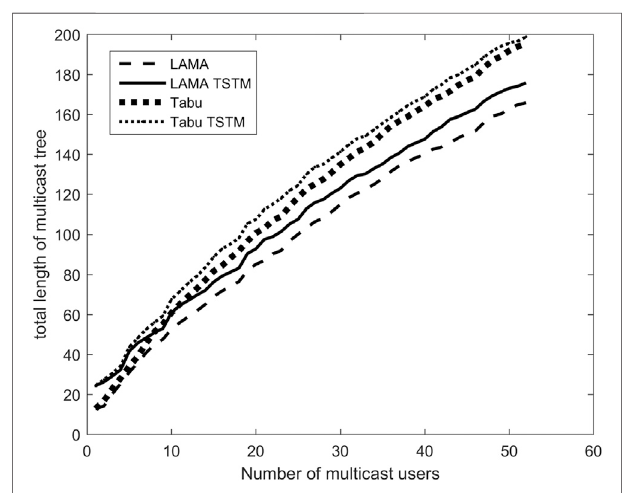
FIGURE 9 | The total length of multicast trees on different algorithms.